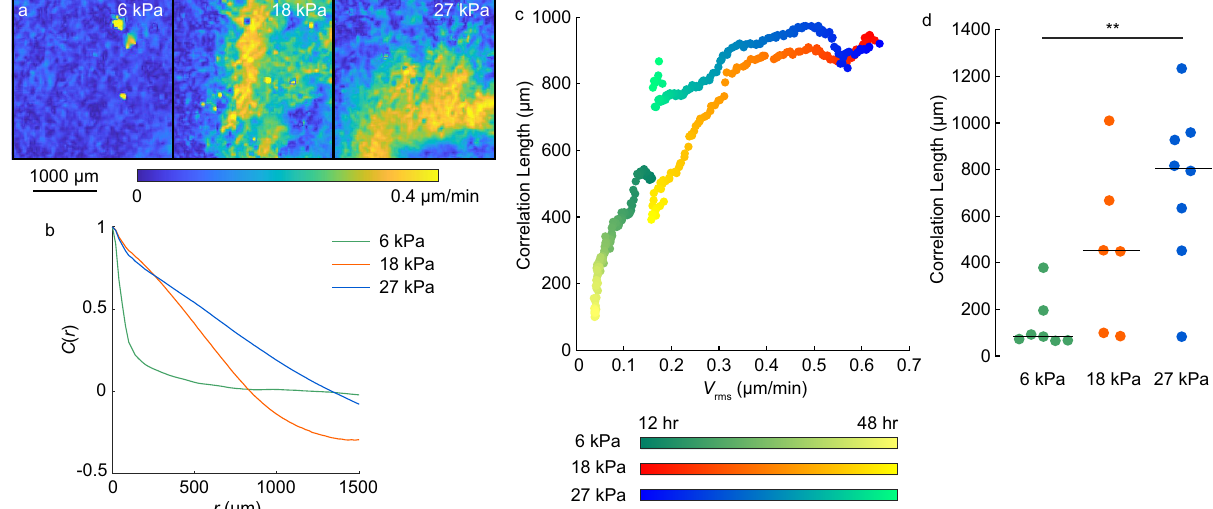
Figure 2. Effect of substrate stiffness and time in culture on RMS velocity and velocity correlation length. ( a ) Representative color maps of speed of cells on substrates of moduli 6, 18, and 27 kPa at t = 45 h after the cells reached confluence. ( b ) Autocorrelation of cell velocity C ( r ) plotted as a function of separation distance r at t = 45 h for a representative cell layer on each substrate stiffness. ( c ) Velocity correlation length plotted against RMS velocity. The brightness indicates time after confluence and the color family indicates substrate stiffness as indicated in the legend. Each data point represents the average of at least 6 statistically independent samples on each substrate stiffness. ( d ) Velocity correlation length for each substrate stiffness. Data shown represent averages over time points collected in the range t = 42–48 h after confluence. Each dot represents an independent measurement; horizontal lines indicate